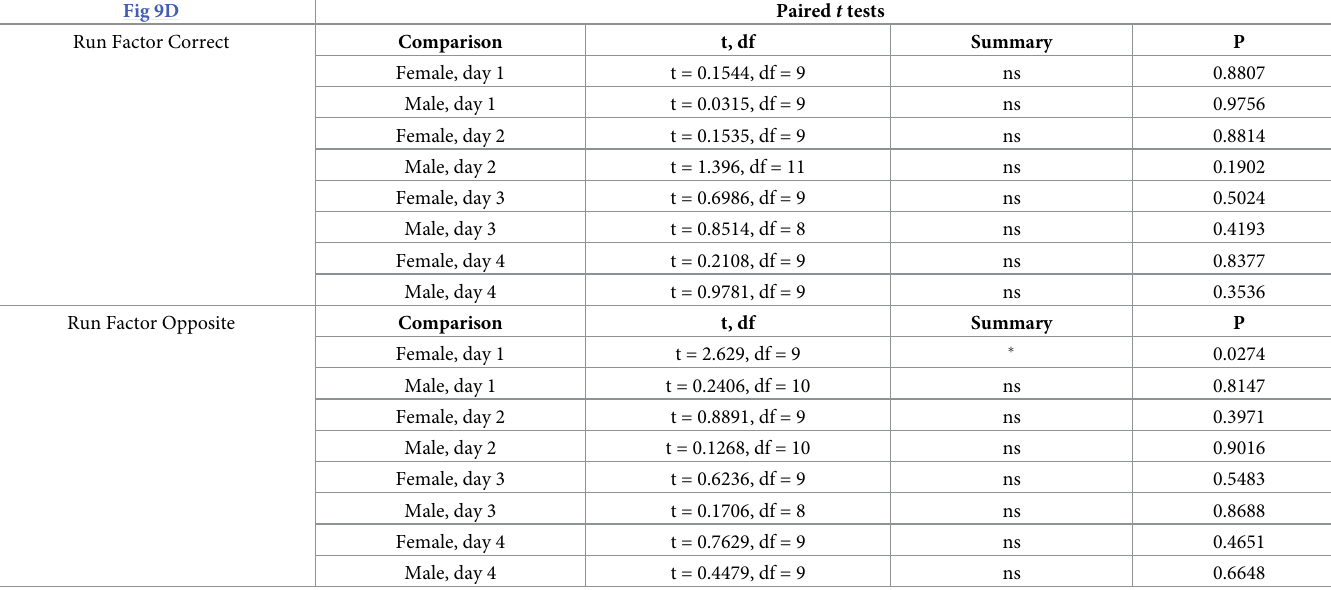
Table 15. Statistical analysis of data shown in Fig 9D for serial reversal, cohort A, Run